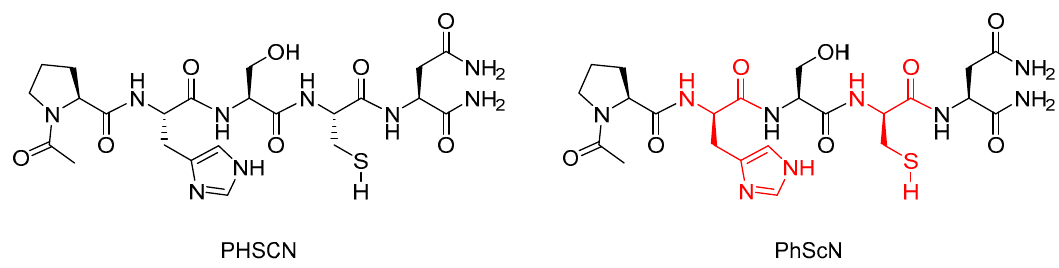
Figure 6. Structures of PHSCN and PhScN peptides, with the D -amino acids highlighted in red [59].